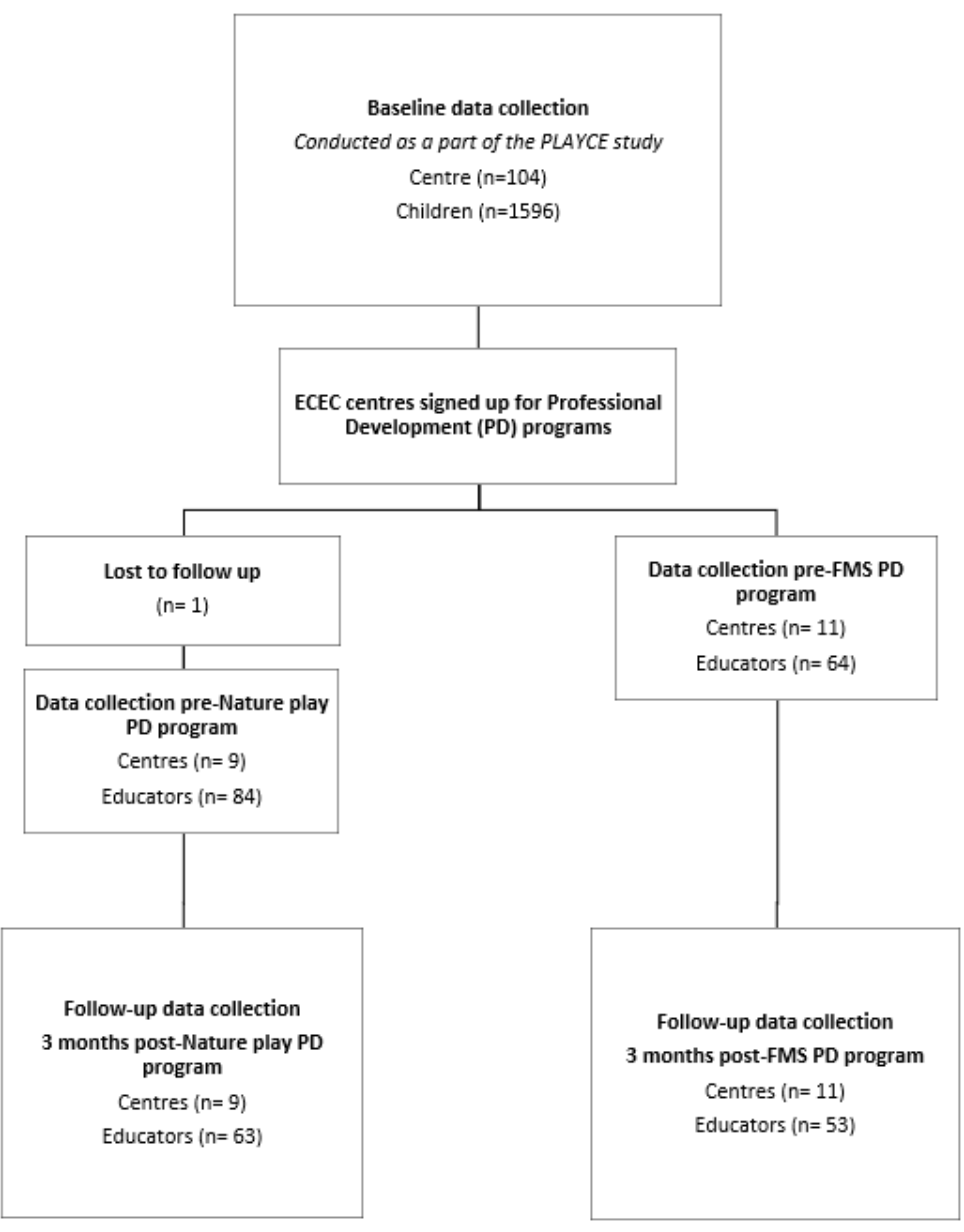
Figure 1. Overview of the study design and recruitment process. ECEC: Early Childhood Education and Care; PLAYCE: Play Spaces and Environments for Children’s Physical Activity; FMS: Fundamental movement skills.